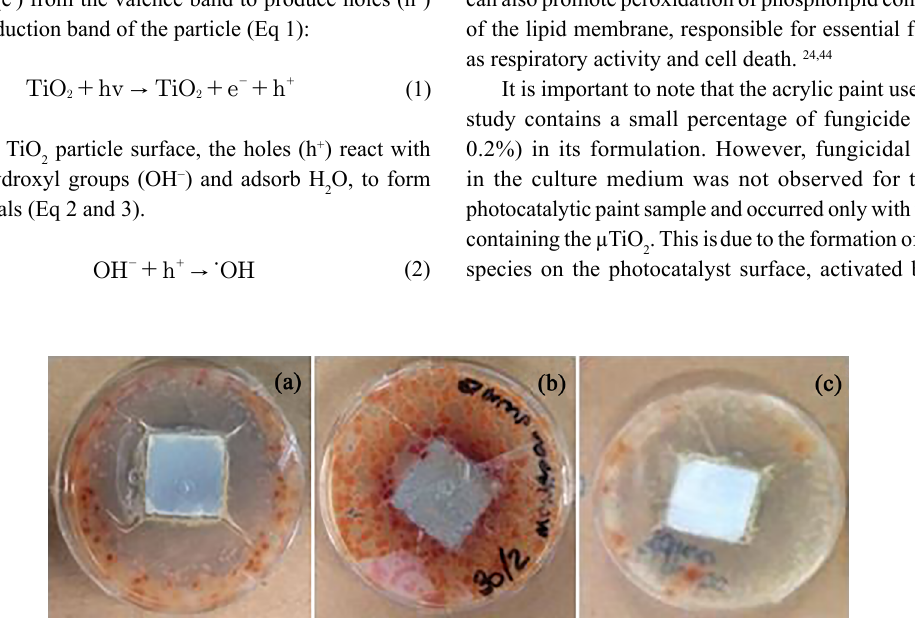
P25, after the fungal test 2